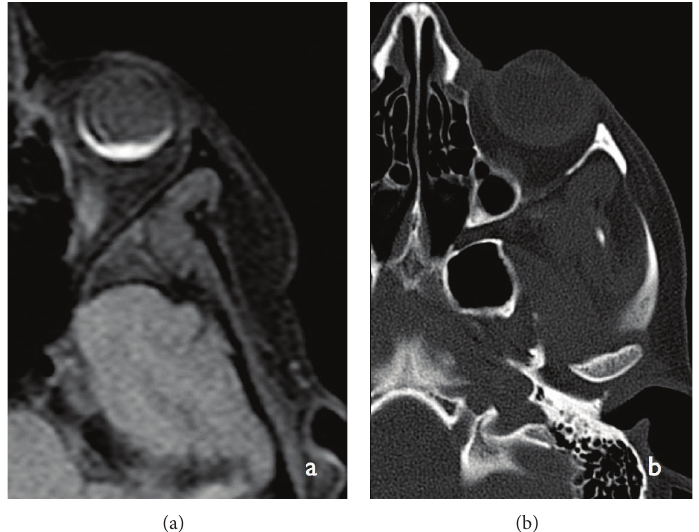
Figure 4: Axial T1-weighted image MRI (a) showing hyperintense lesion in the retinal choroid with a mild exophytic thickening of the uvea. Axial noncontrast enhanced CT section (b) in bone window projection showing the lesion to be of soft tissue densities without